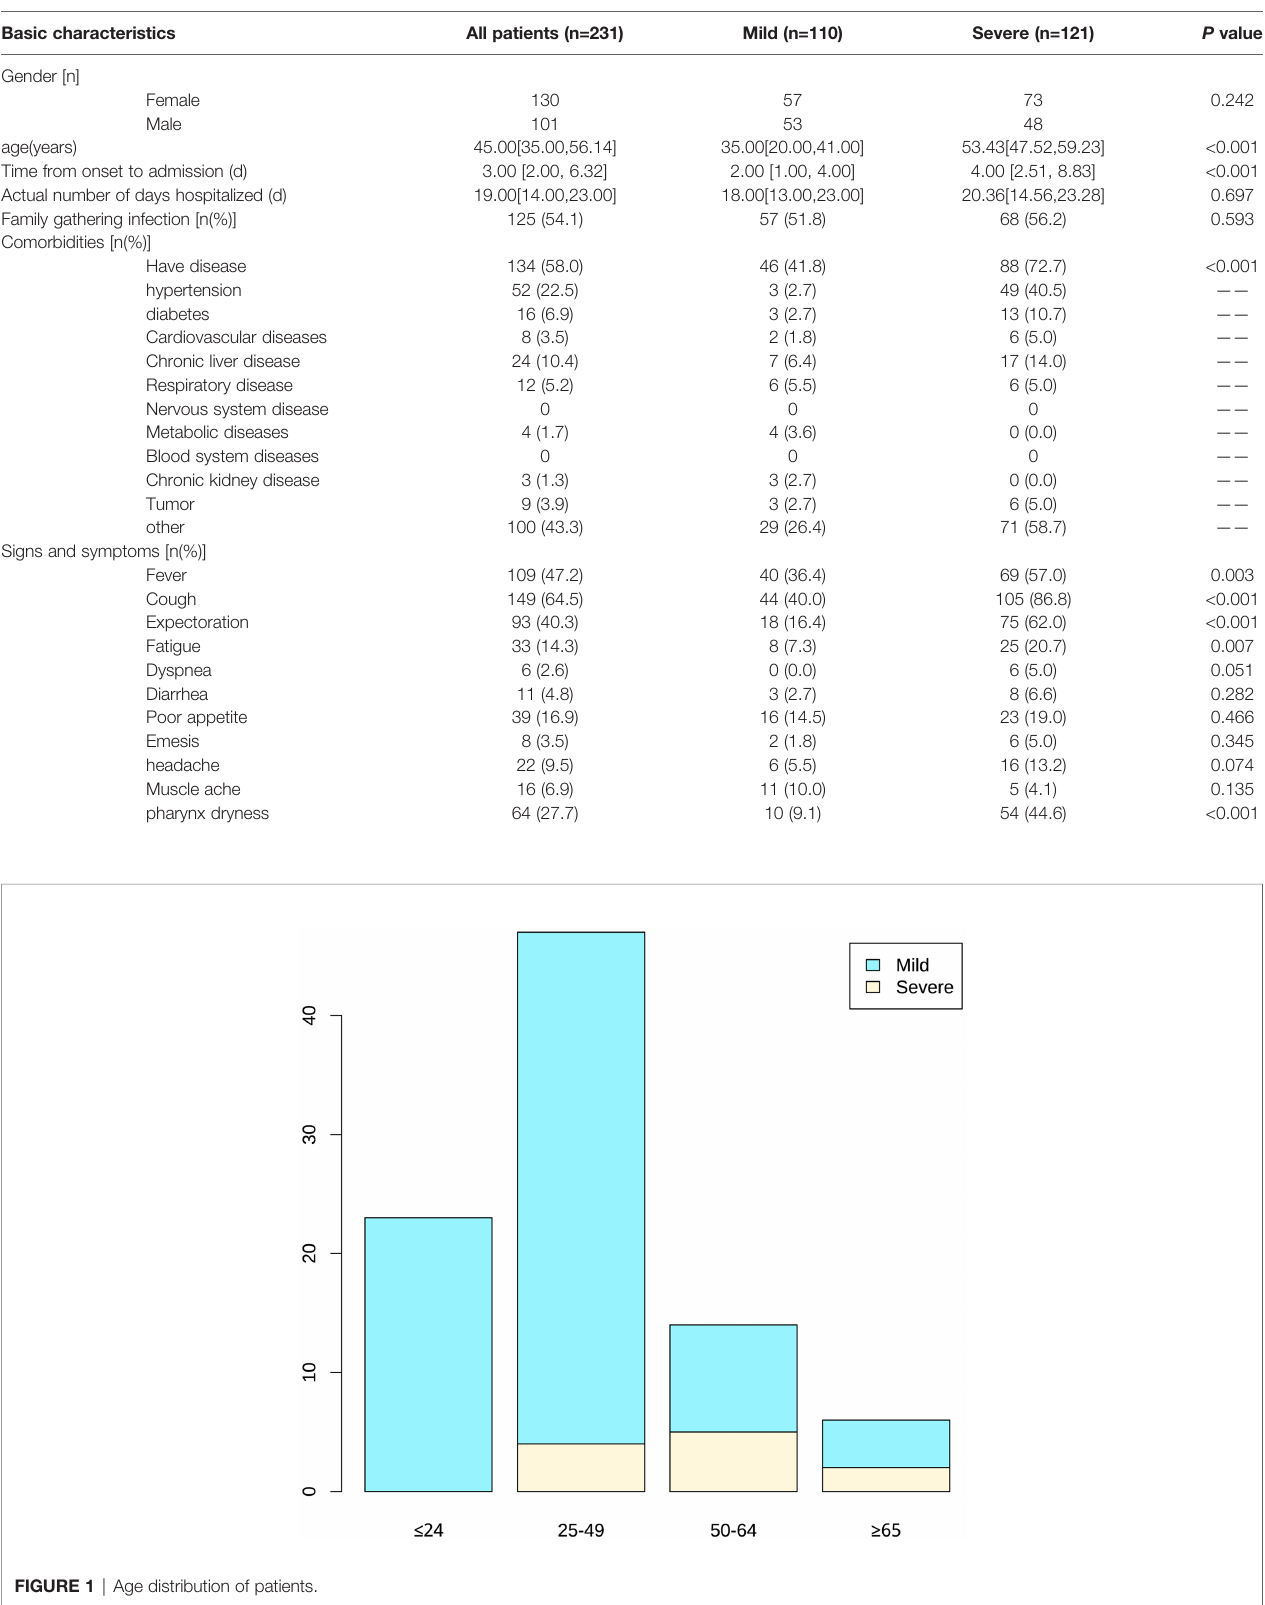
TABLE 1-2 | The demographic and clinical characteristics of patients infected with COVID-19 after SMOTE balance data. Basic characteristics